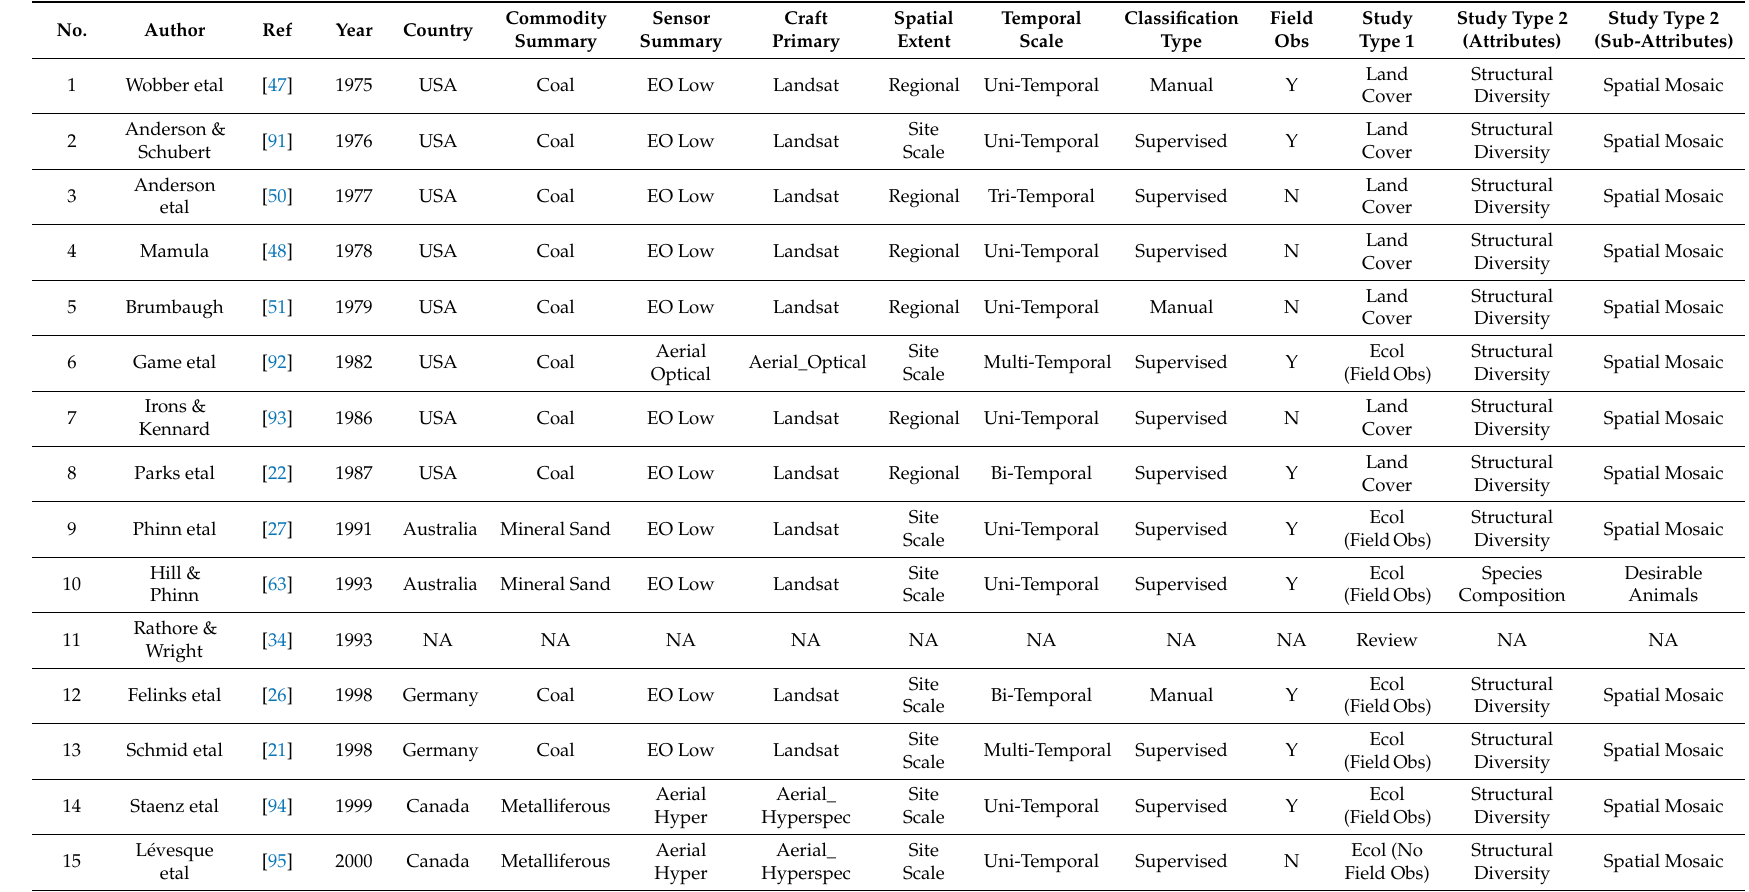
Table A2. A summary of the 99 papers used in the study, sorted by year of